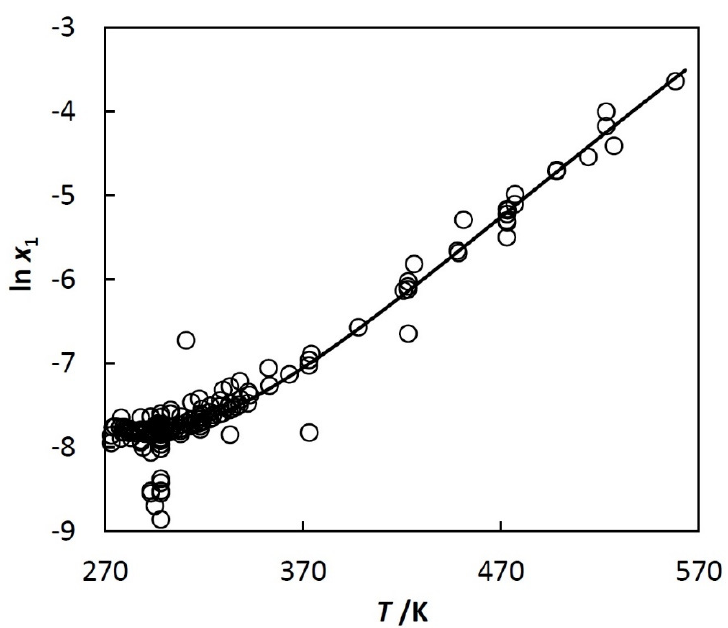
Figure 2. Solubility of benzene (1) in water (2), natural logarithm of mole fraction of benzene (1) in water (2), ln x 1 , vs. temperature, T .